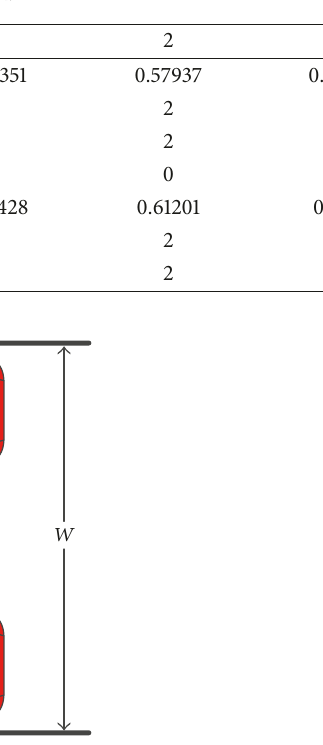
Table 2: Output modification of the BP neural network.